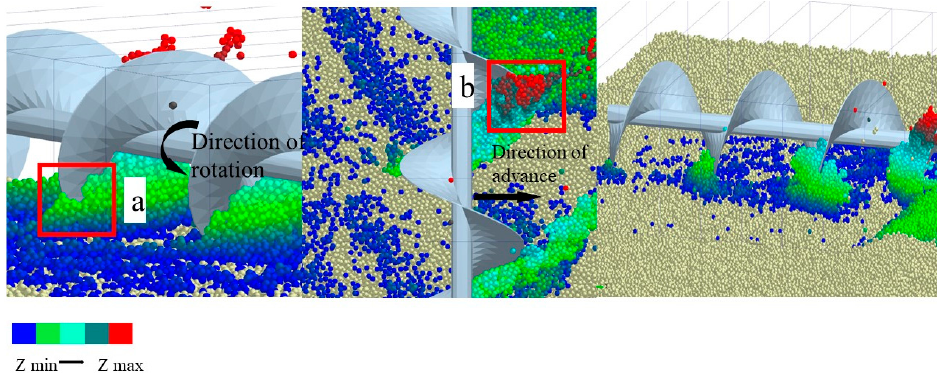
Figure 9. Soil separating process. ( a ) soil particles below the spiral blades. ( b ) soil particles in front of the spiral blades.